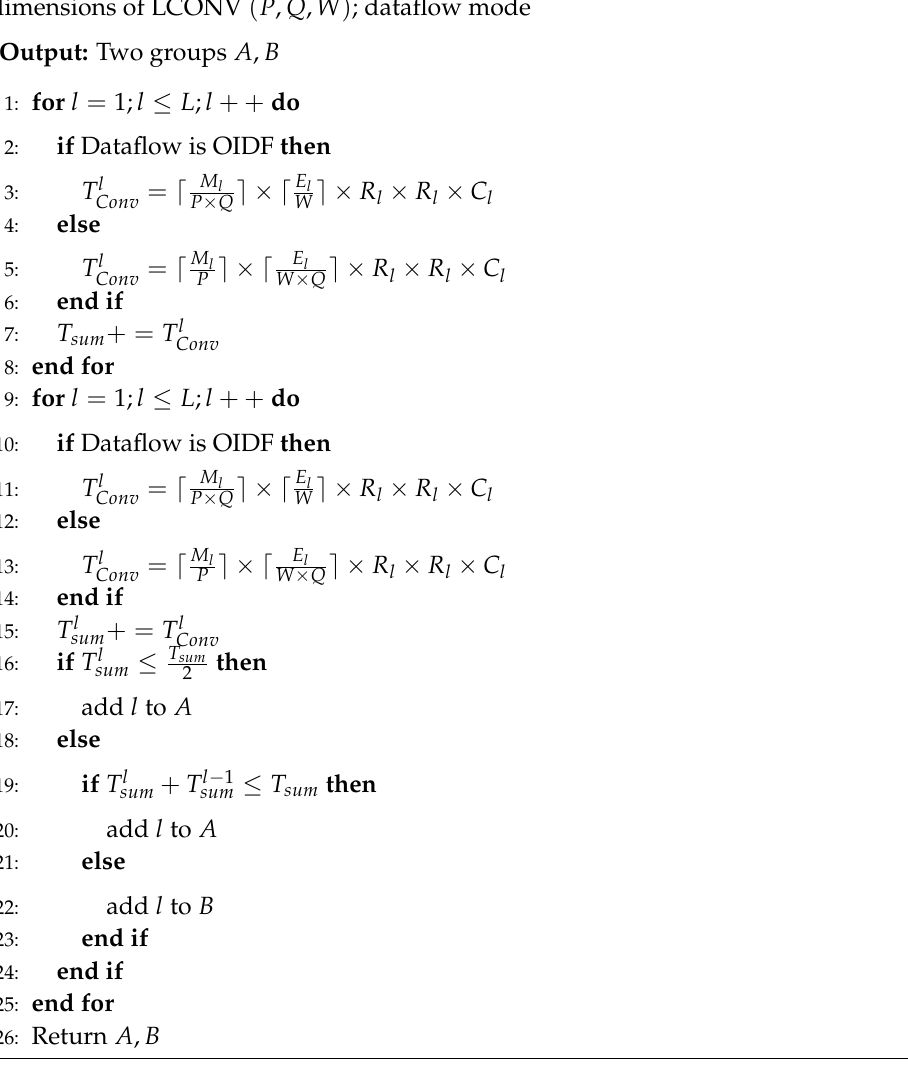
Algorithm 1 Coarse Grain Task